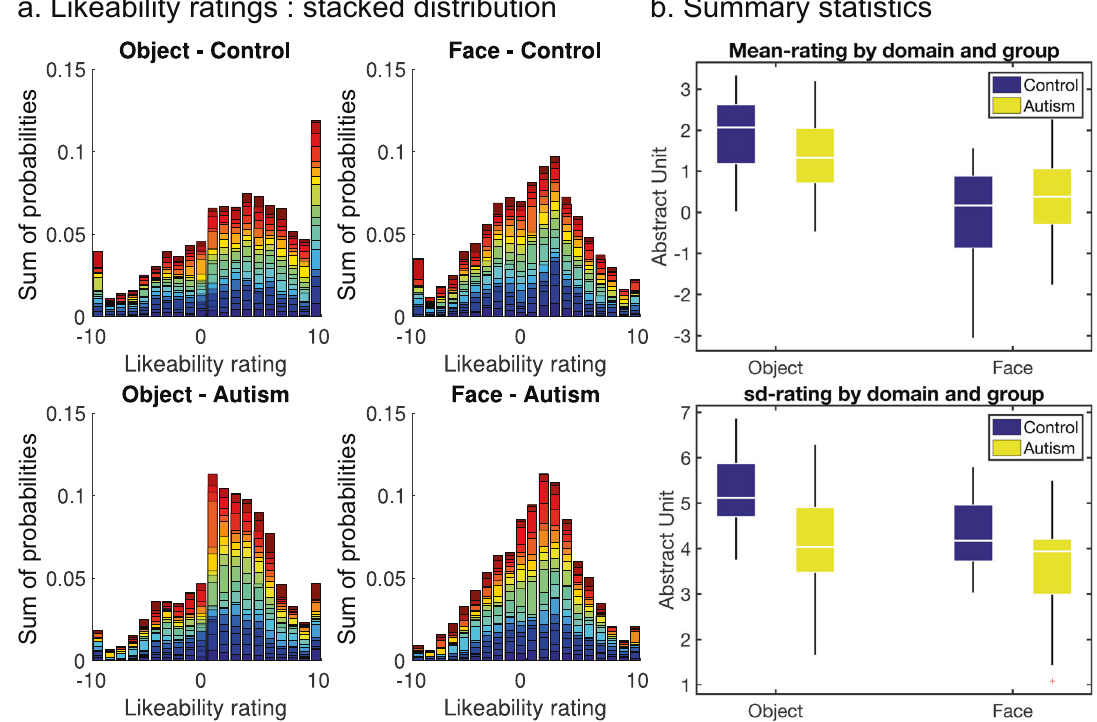
Fig. 2 Likeability ratings. a Individual data. Panels show stacked histograms of likeability ratings for both groups (top: control participants, bottom: autistic participants) and both domains (left: objects, right: faces). In both groups, each participant is represented with a different (arbitrary) color. For each group and domain, data were normalized such that the grand sum of all bins and all participants is equal to 1. b Summary group-level statistics. Top panel shows the mean, while the bottom panel shows the standard deviation of likeability rating (across items). White line: median, points are drawn as outliers if they are larger than Q3 + 1.5 × (Q3 − Q1) or smaller than Q1-1.5 × (Q3 − Q1), where Q1 and Q3 are the 25th and 75th percentiles, respectively. Vertical error bars are inter-participant